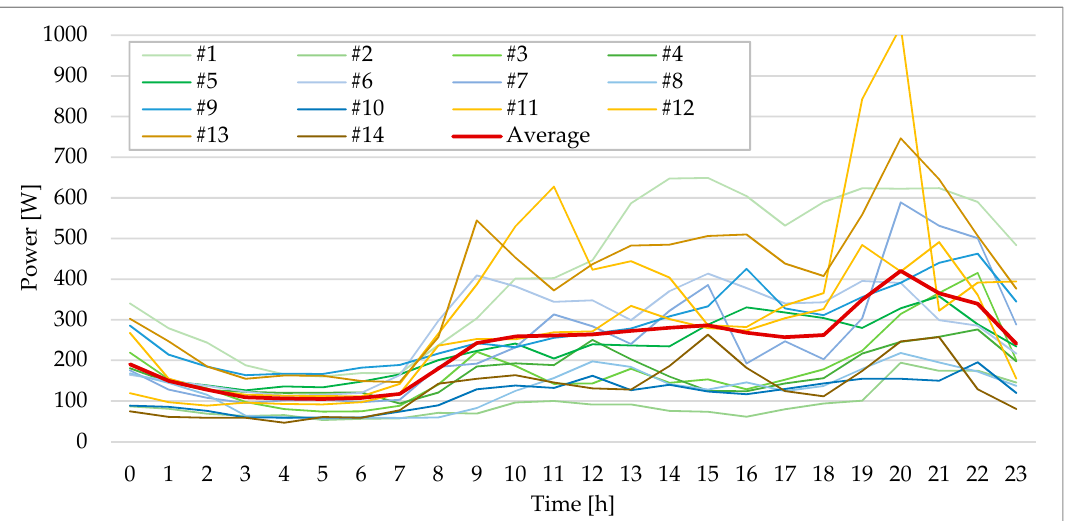
Figure 8. Archetypes average daily profiles over non-working days.